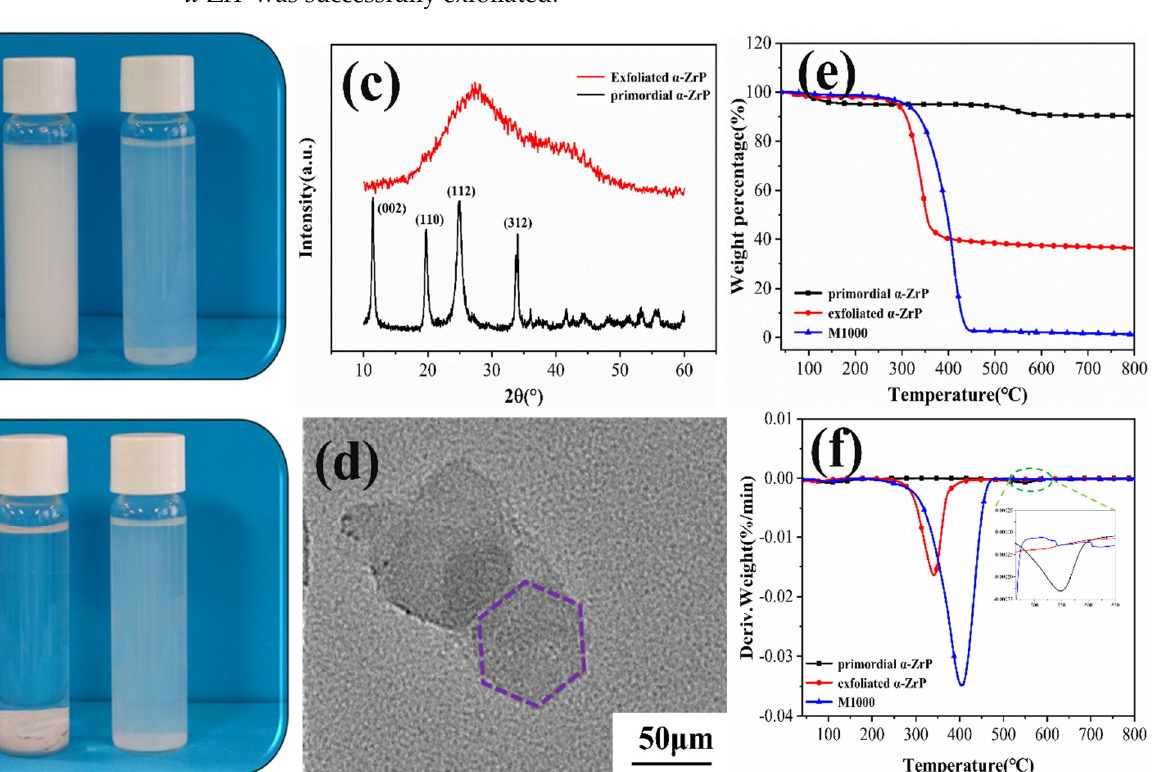
4 of 23 Figure 1. Analyses of α -cellulose and PCF: ( a , b ) FTIR spectra; ( c ) TGA curves; and ( d ) DTG curves. 2.2. Chemical Structure and Morphological Analysis of α -ZrP